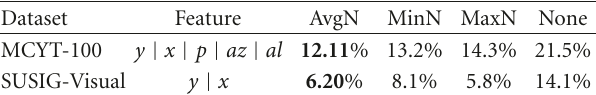
Table 4: Di ff erent methods for user-dependent distance normaliza- tion using only the reference data.